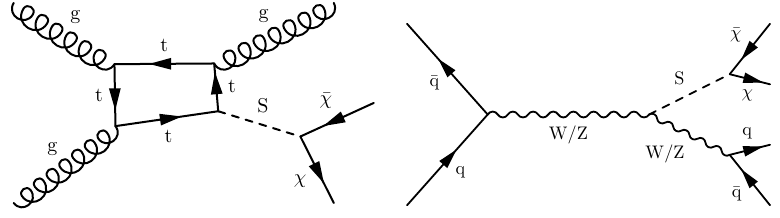
Figure 2 . Leading order Feynman diagrams of monojet (left) and mono-V (right) production and decay of a spin-0